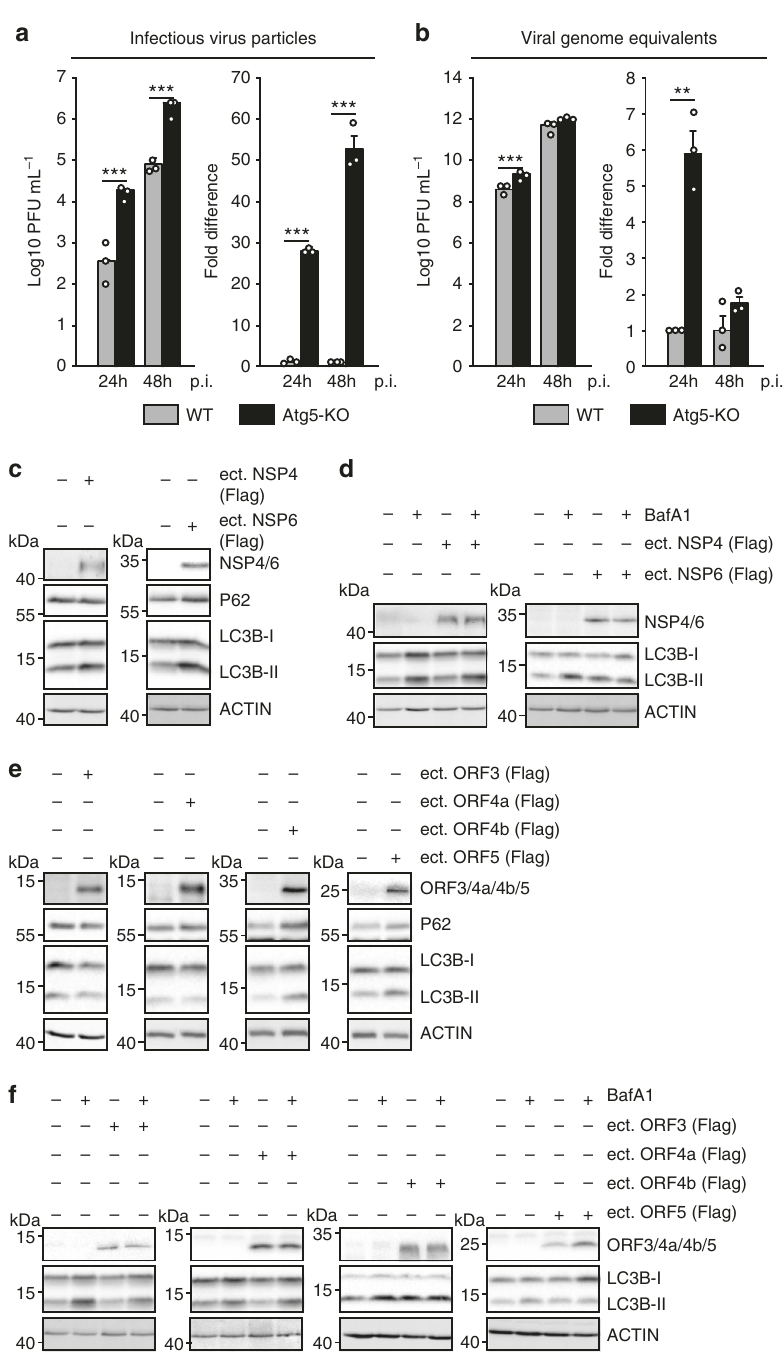
Fig. 7 Mutual in fl uence of MERS-CoV and autophagy. a , b Deletion of ATG5 in VeroB4 cells facilitates MERS-CoV replication. VeroB4 wt or Atg5 knockout cells were infected with MERS-CoV (MOI = 0.001). Plaque forming units (PFU, a ) and genome equivalents (GE, b ) per ml were determined by plaque assay or quantitative real time RT-PCR, at 24 and 48 h p.i.. Fold difference and absolute numbers per ml are displayed. In all panels, error bars denote the standard error of the mean, derived from n = 3 biologically independent experiments. ** p < 0.01, *** p < 0.001 ( t -tests, details in Supplementary Table 2). c – f MERS-CoV NSP4, NSP6 ( c , d ) p3, p4a, p4b, and p5 ( e , f , all proteins were Flag-tagged at the N-terminus) were transiently expressed in VeroB4 cells and the indicated proteins were determined by western blotting after 72 h. BafA1 (0.1 µ M) was added 2 h before harvesting to assess the autophagic fl ux ( d , f ). Western blots are representative of three independent experiments. Source data and blot collections are provided as a Source Data fi fl ux (Fig. 9a, Supplementary Fig. 8a, b, Supplementary Table 3) increased the number of autolysosomes more than twofold (Supplementary Fig. 9f, g). NIC also affected the autophagic fl ux and comparable to SKP2i (see Fig. 5e, f, Supplementary Fig. 2e, f). in the infected cells similar to SKP2i (Supplementary Fig. 9h, i). NIC and VAL reduced MERS-CoV multiplication by up to 1000- Therefore, these three compounds were tested for their dose- fold at 48 h p.i. (Fig. 9b, Supplementary Fig. 9a – c). Thus, NIC and effect relationship in a MERS-CoV infection experiment. All VAL were characterized further. Both drugs enhanced ATG14 compounds showed high ef fi cacy, ( I maxSKP2i = 28,000 fold, oligomerization about twofold (Supplementary Fig. 9d, e) and